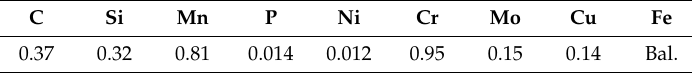
Table 1. Chemical composition of Cr-Mo steel (mass%).